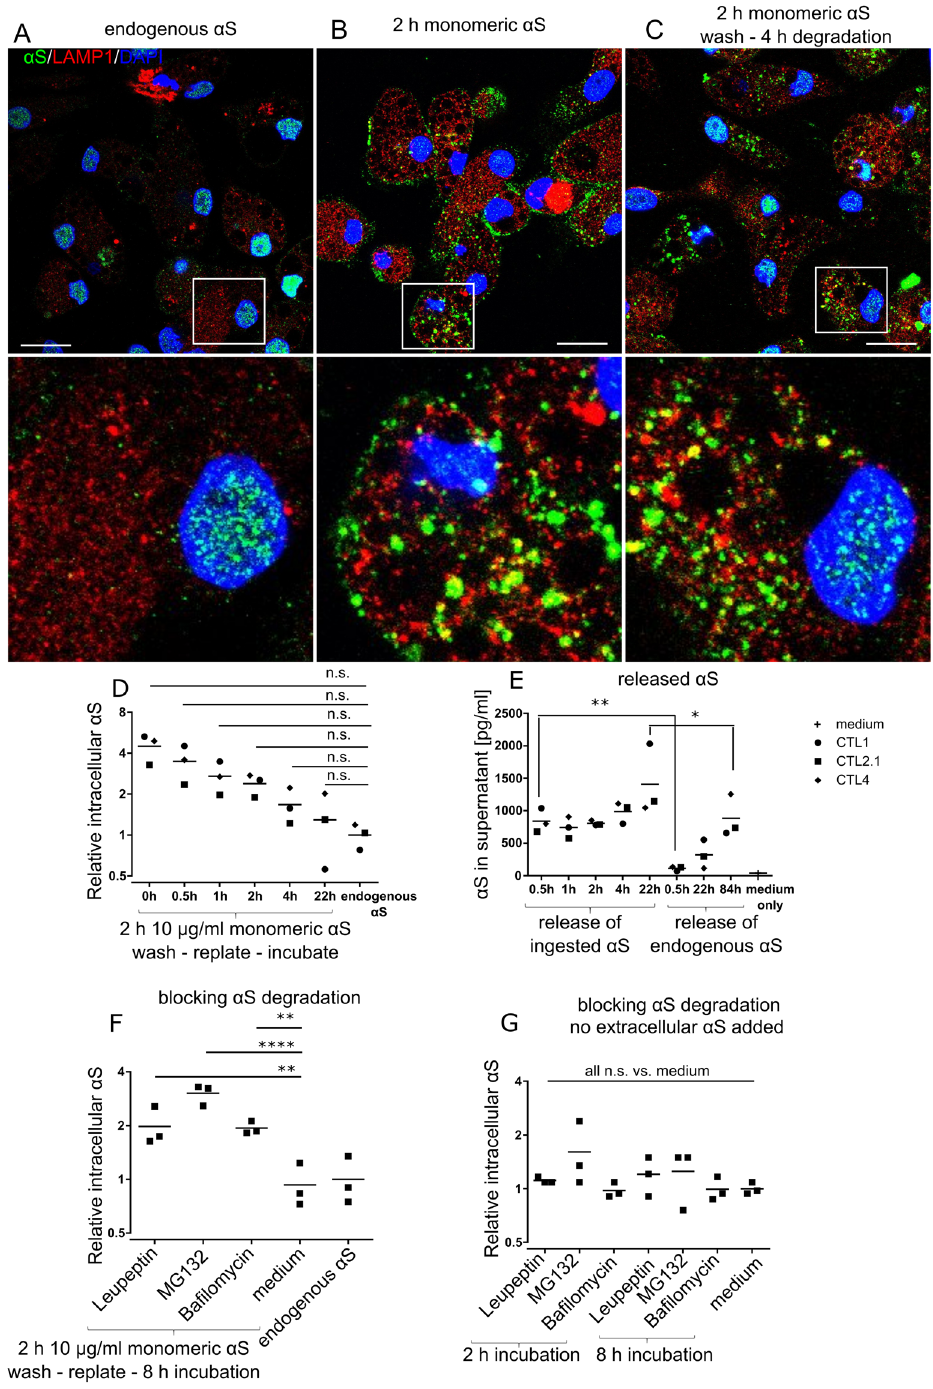
Figure 5. pMac degrade exogenous α S. ( A ) Immunocytochemistry of pMac: α S (green); lysosomal marker LAMP1 (red); nuclei (DAPI, blue; scale bar = 20 µ m), region within white square is magnified below. ( B ) As ( A ) but pMac treated for 2 hrs with 10 µ g/ml α S. ( C ) As ( B ), but pMac then washed and replated (4 hrs). ( D ) pMac incubated for 2 hrs with 10 µ g/ml monomeric α S, washed and replated for the indicated number of hrs before assaying for intracellular α S by FACs; MFI relative to endogenous α S in untreated pMac. ( E ) Release of α S to supernatant of same experiment as ( D ). ( F ) As ( D ), with the addition of degradation pathway-specific drugs upon replating pMac after α S exposure and incubation for 8 hrs. ( G ) Pathway-specific drugs were added to cells (without exogenous α S exposure) for 2 and 8 hrs and assayed for intracellular accumulation of endogenous α S by FACs. ( F , G ) 1 line, 3 independent differentiations. Statistical analyses: ( E ) two-tailed t-test; ( D , F , G ) one way ANOVA with Dunnett’s multiple comparisons